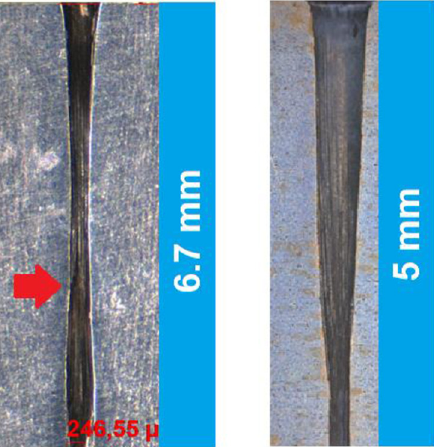
Fig. 10. Typical cross-sections of the laser-drilled, 6.7 mm (left) and 5 mm (right) deep microholes for the deep drawing application. The red arrow indicates the “ quality depth limit ” .